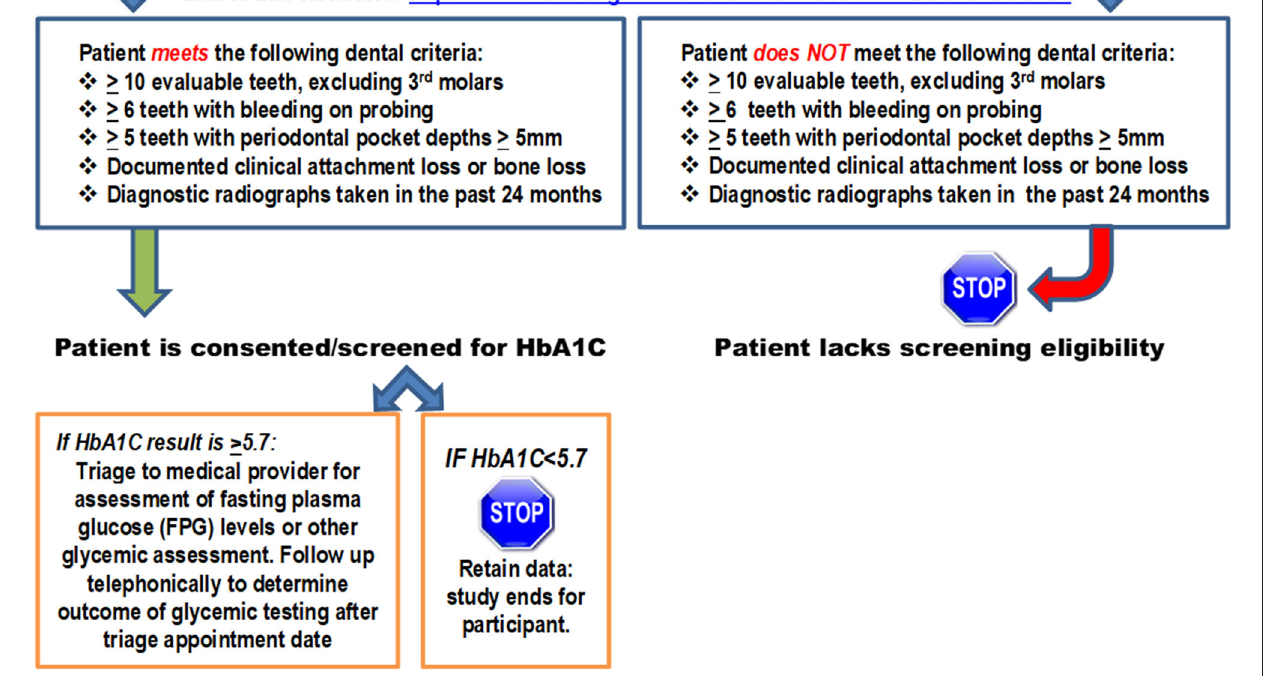
FIGURE 1 | Study flow diagram for study-eligible dental patients. HbA1c measurement, has FDA approval for CLIA-waived POC HbA1c screening in the clinical setting, and reproduces results of the validated laboratory reference method HA 8160